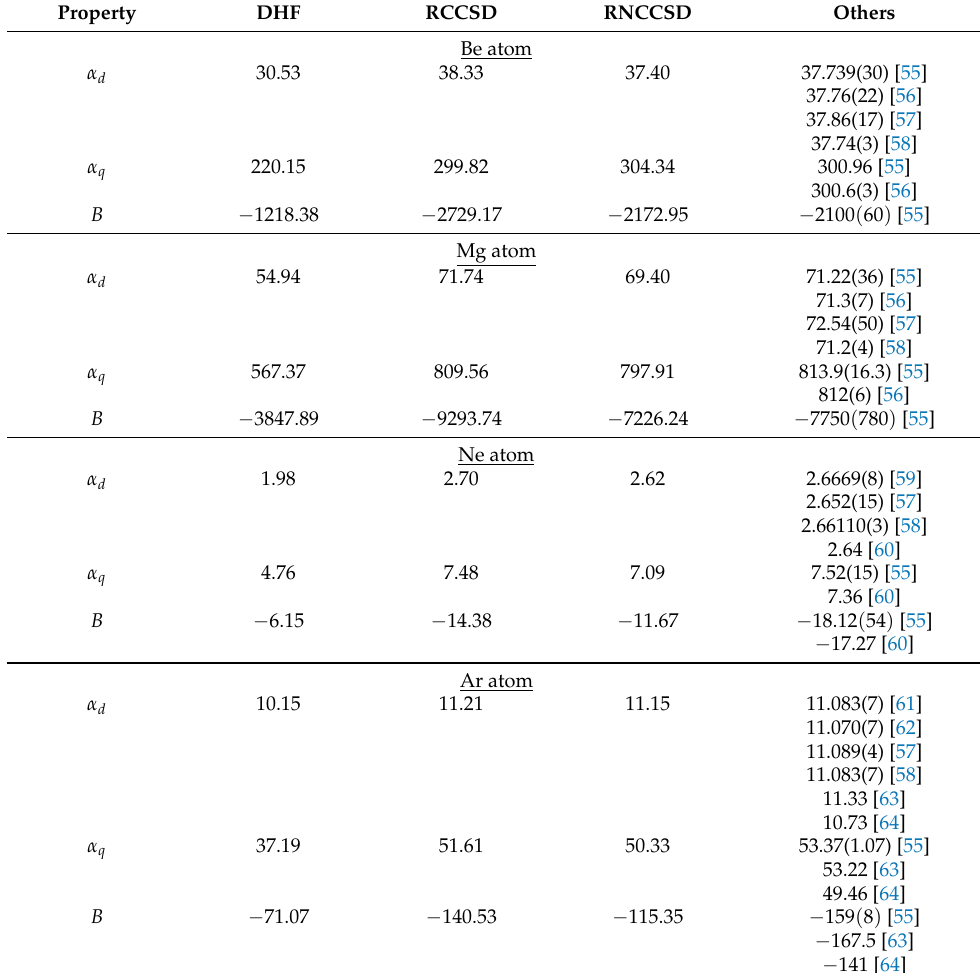
Table 1. Our calculated values of α d , α q and B (in a.u.) of the Be, Mg, Ne and Ar atoms from the DHF, RCCSD and RNCSSD methods. These values are also compared with precise values from the